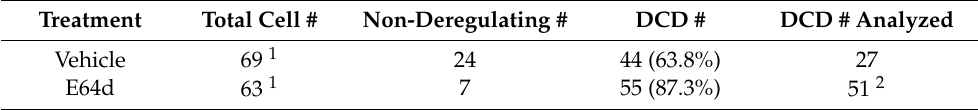
Table 1. Number (#) of cells undergoing delayed calcium deregulation (DCD) or maintaining Ca 2+ homeostasis (non-dereg) in the absence and presence of the cysteine protease inhibitor E64d. Numbers in parenthesis denote the percentage of cells undergoing DCD for each